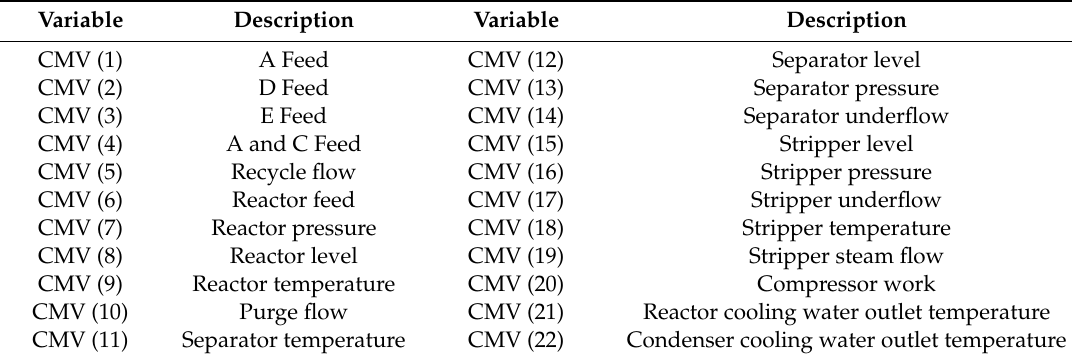
Table 2. Continuous measurement variable (CMV) of the TE process.